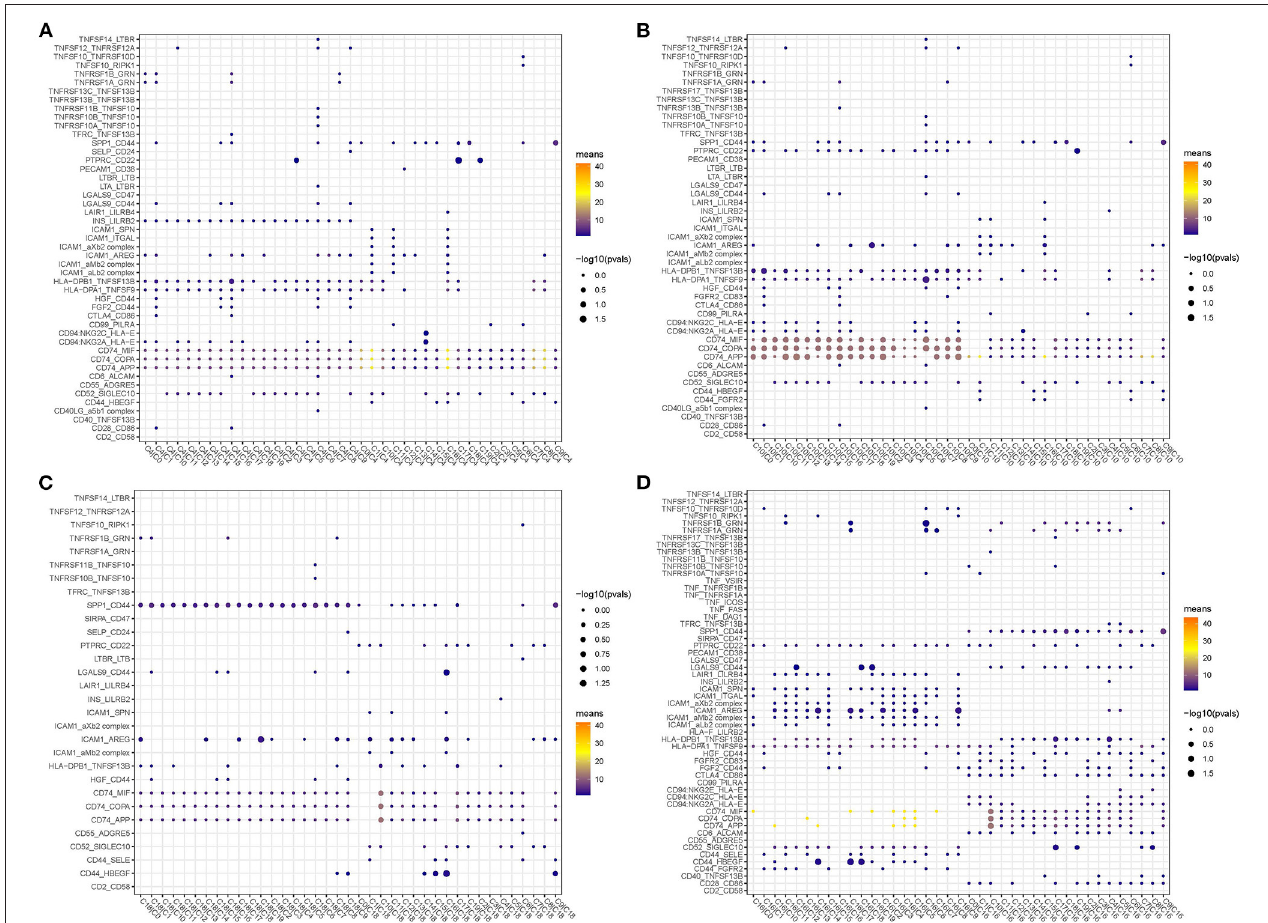
FIGURE 9 | Dot plots of specific ligand–receptor interactions of C4 (A) , C10 (B) , C18 (C) , and C16 (D) to other